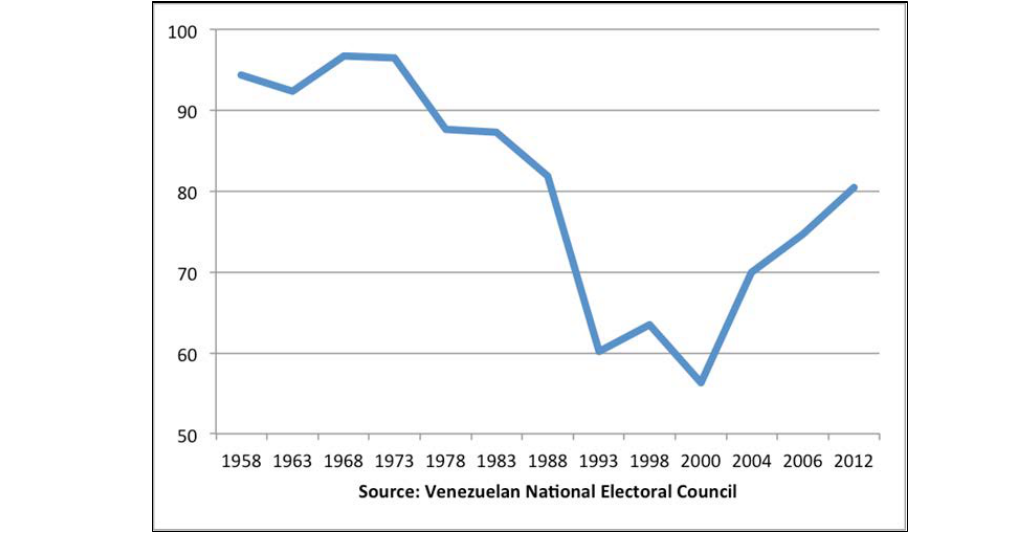
Figure 1: Turnout Venezuelan Presidential Elections,